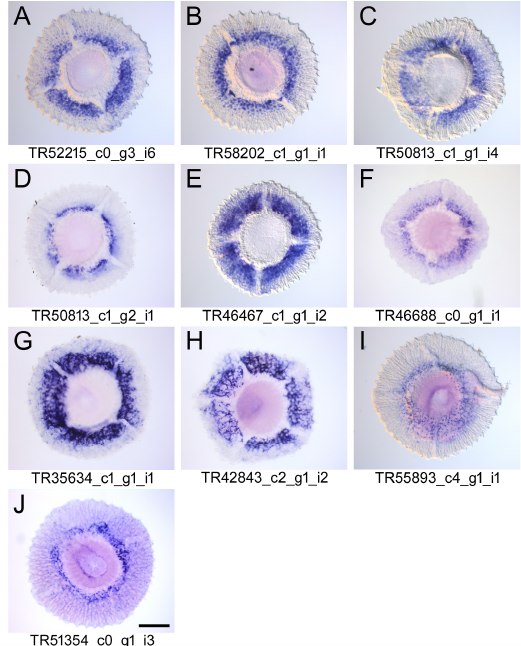
Figure A1. In situ hybridization screen panel 1. ( A – J ) Ventral view onto the tube foot disc. The distribution of the in situ hybridization signal (blue) resembles the localization of the adhesive gland cells bodies. Therefore, these transcripts potentially constitute proteins involved in bioadhesion. Scale bar, 200 µm.